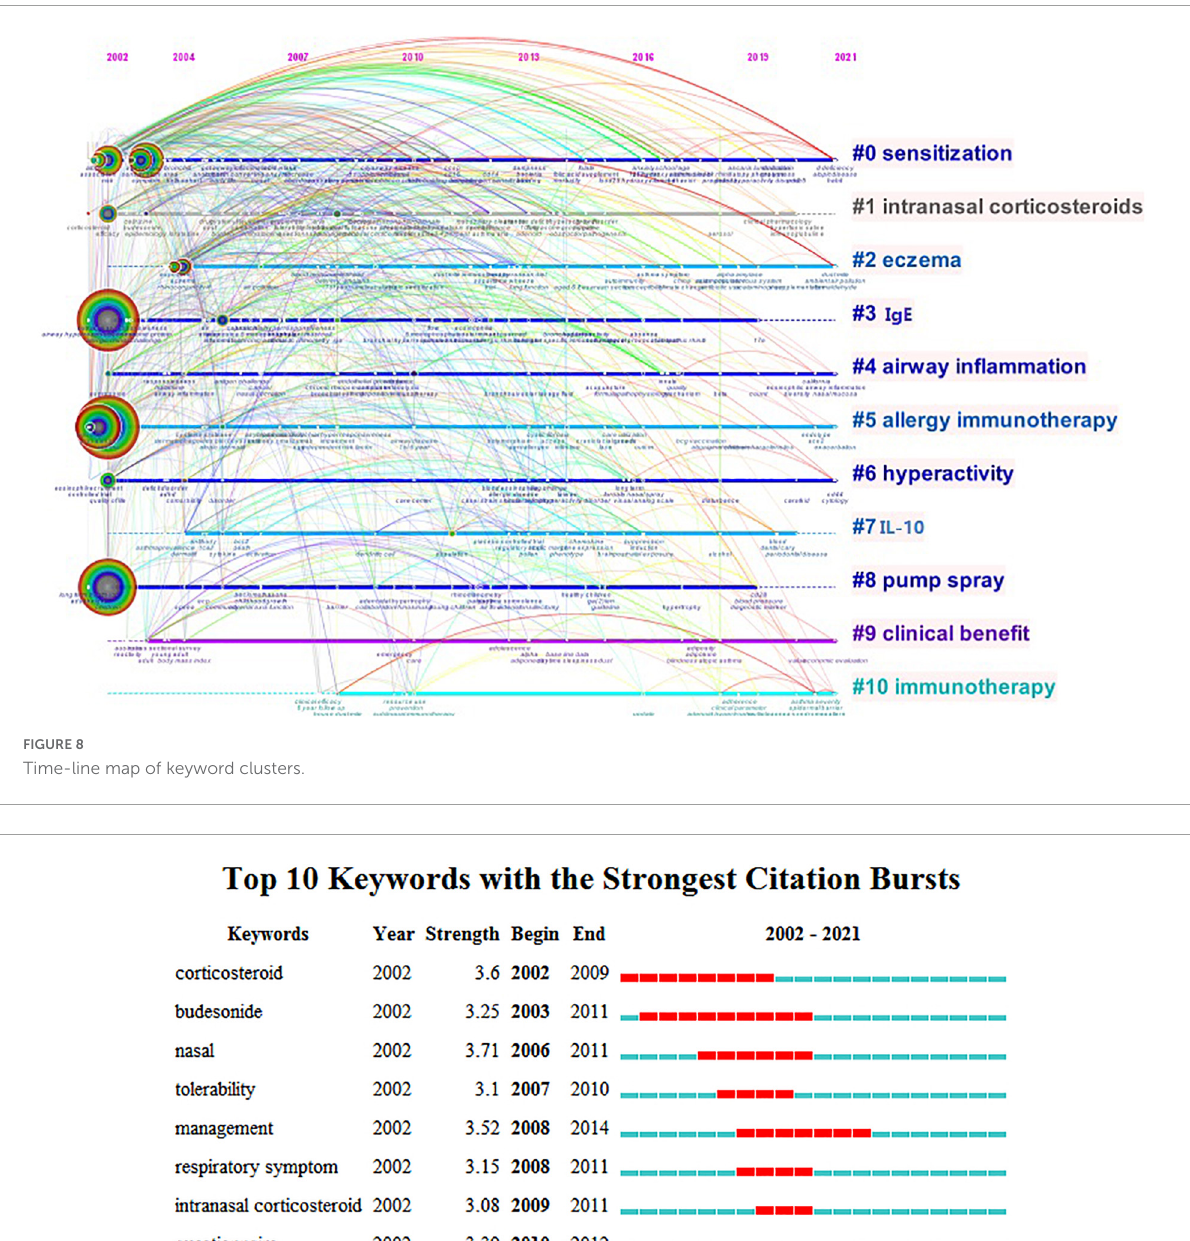
FIGURE9 Top 10 burst keywords of AR research in Children. The blue part represents the base timeline, and the red part indicates the burst duration of the keyword. The strength represents the intensity of hotspots in clinical research of the burst keyword. A greater strength indicates a higher frequency of